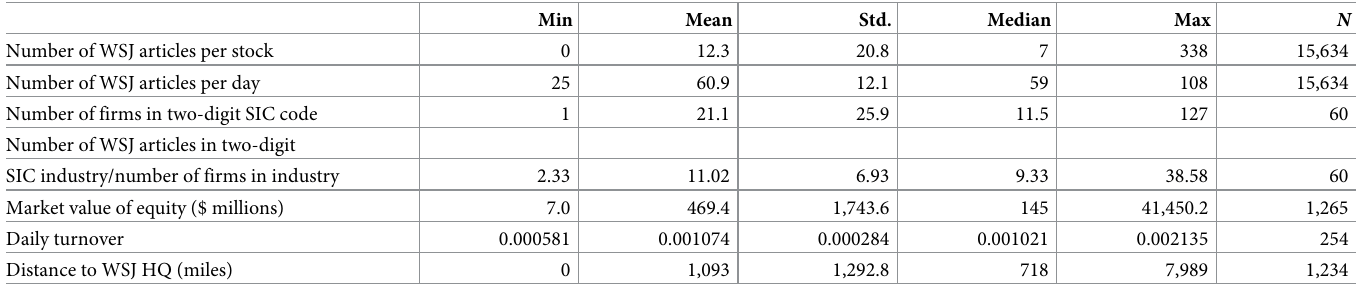
Table 1. Summary statistics on sample of WSJ articles in 1970 as well as NYSE-listed firms that existed in 1970. Min Mean